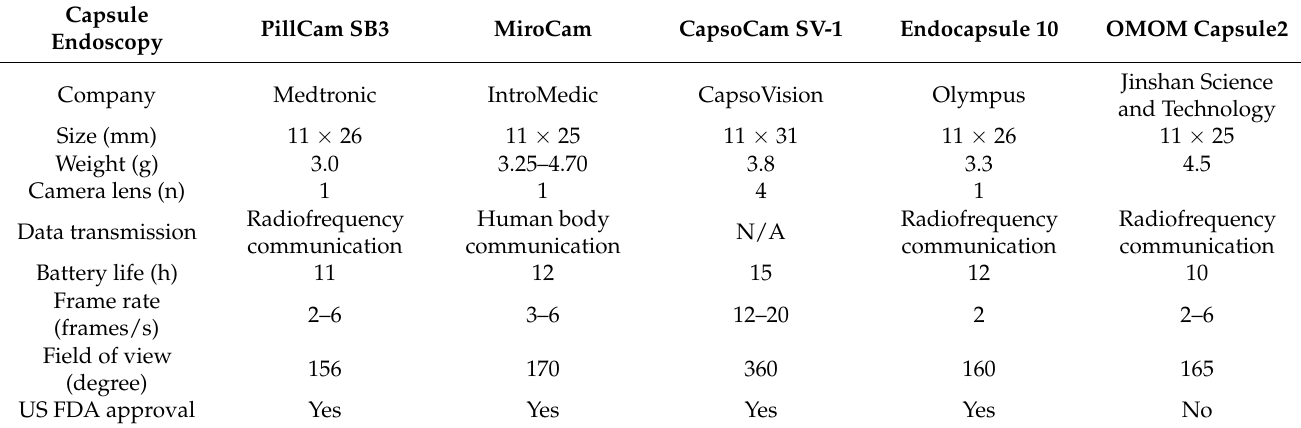
Table 2. Currently available capsule